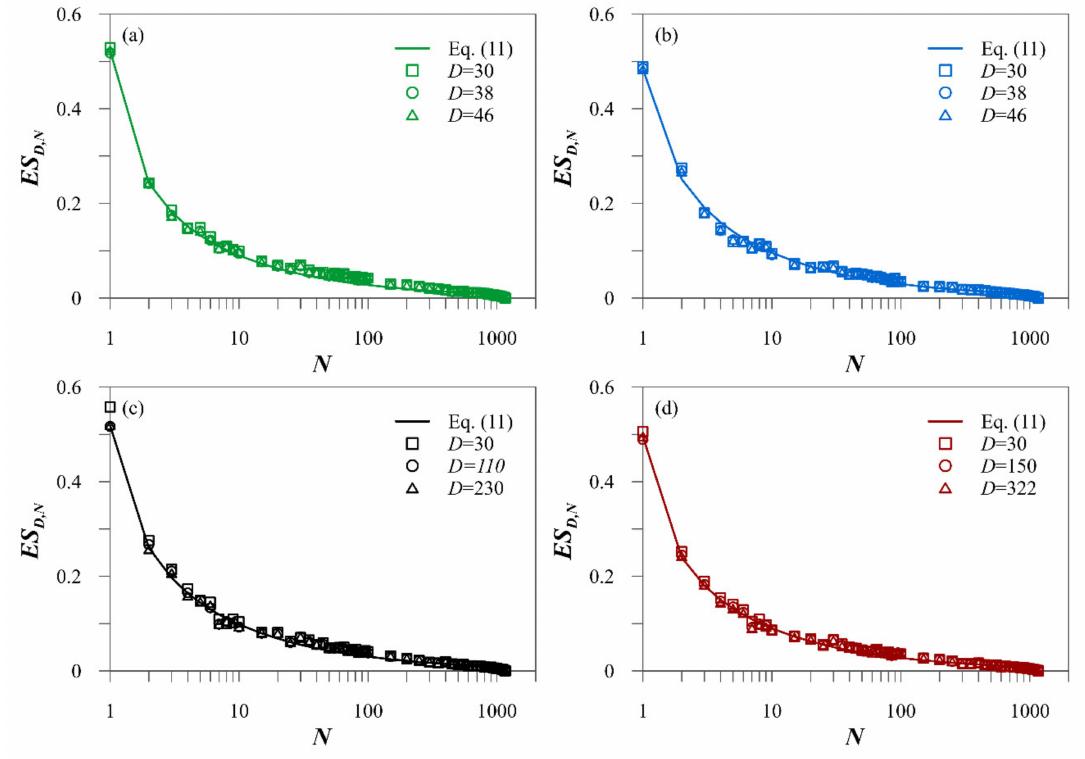
Figure 6. Standard errors of the sample mean estimated by Equation (9) and predicted by Equation (11) for three di ff erent D for: ( a ) Cluster 1; ( b ) Cluster 2; ( c ) Cluster 3; ( d ) Cluster